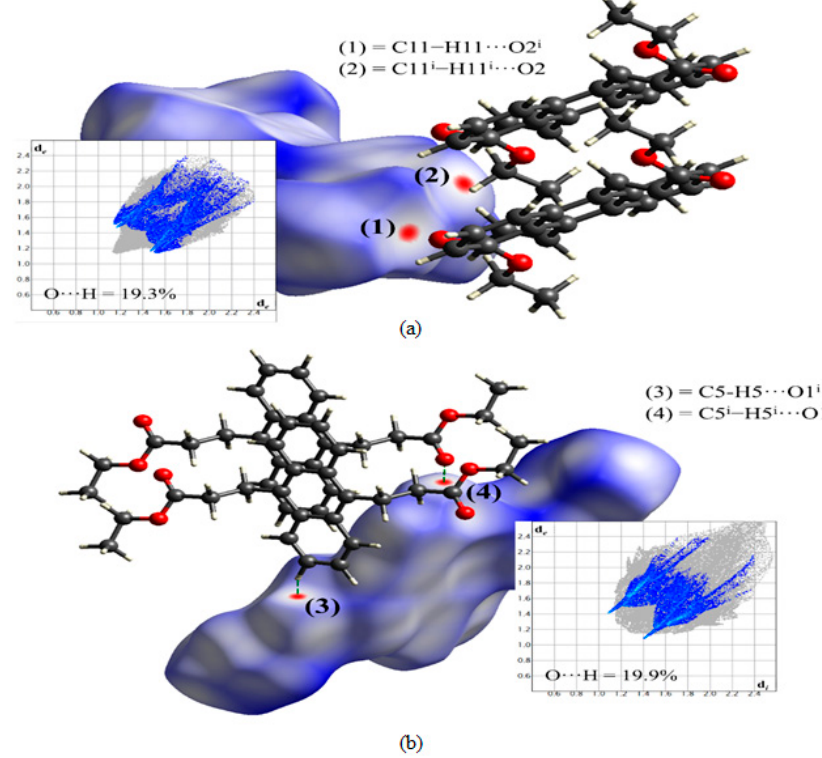
Figure 7. Hirshfeld surface d norm confirming the intermolecular interactions of DADB ( a ) and the 2D fingerprint plot of O–H contacts ( b ).